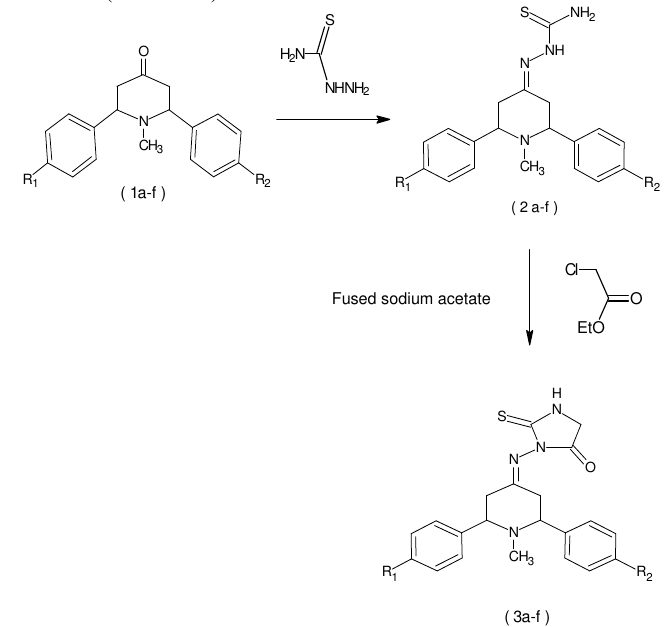
Scheme 1. Synthesis of 4-thioxo-imidazolidin-2-one